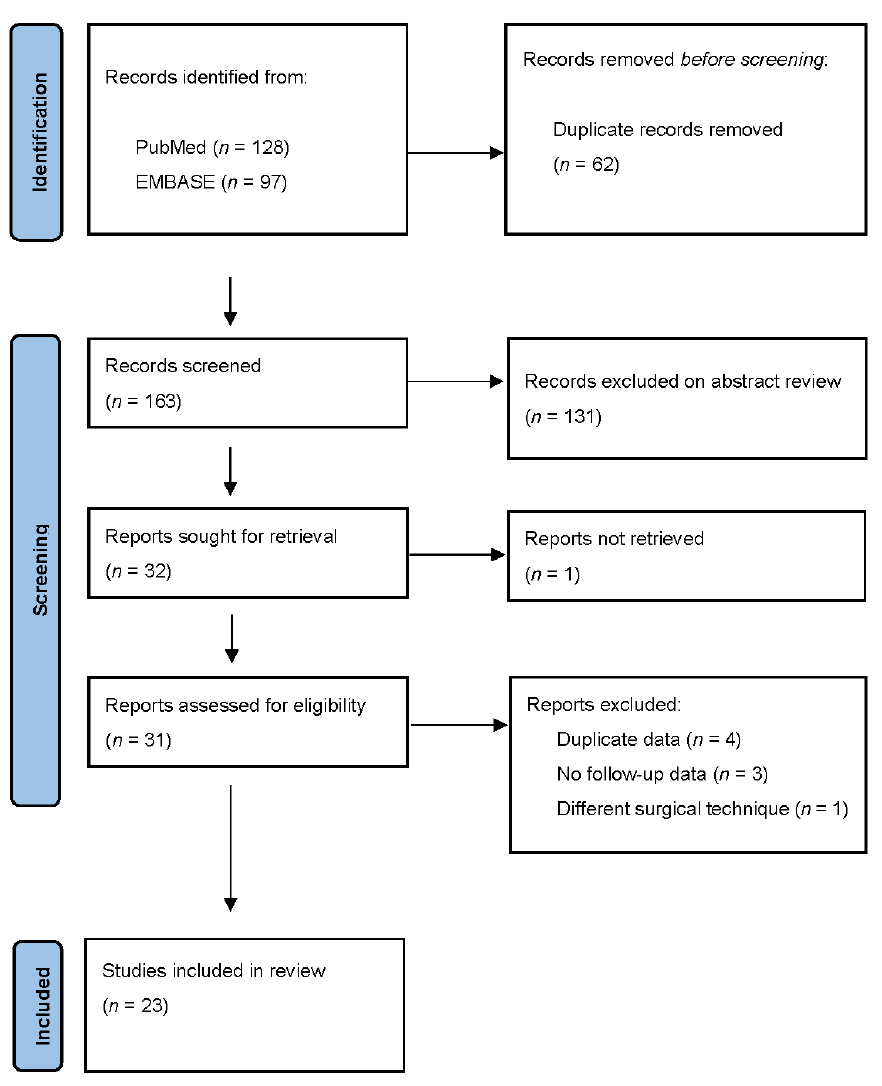
Figure 2. PRISMA study selection flow diagram.